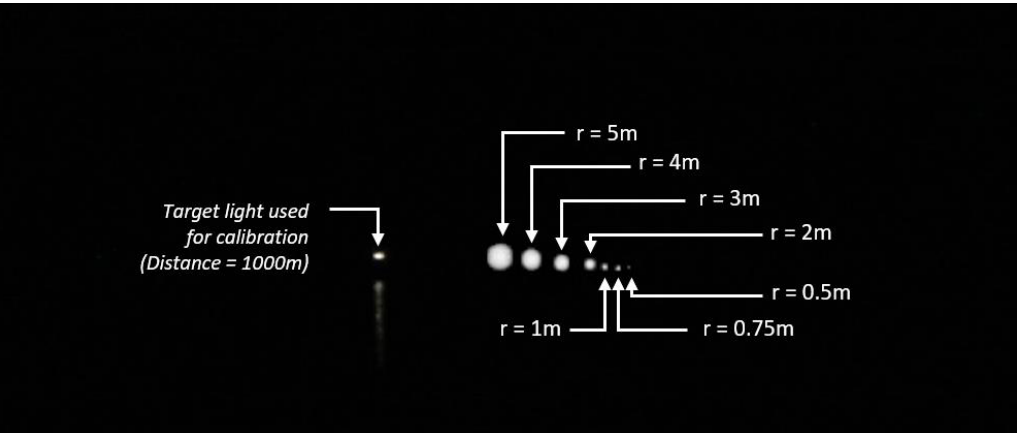
Figure 7. Comparison of light and spheres at a distance over water of 1000 m (Lake St Clair).